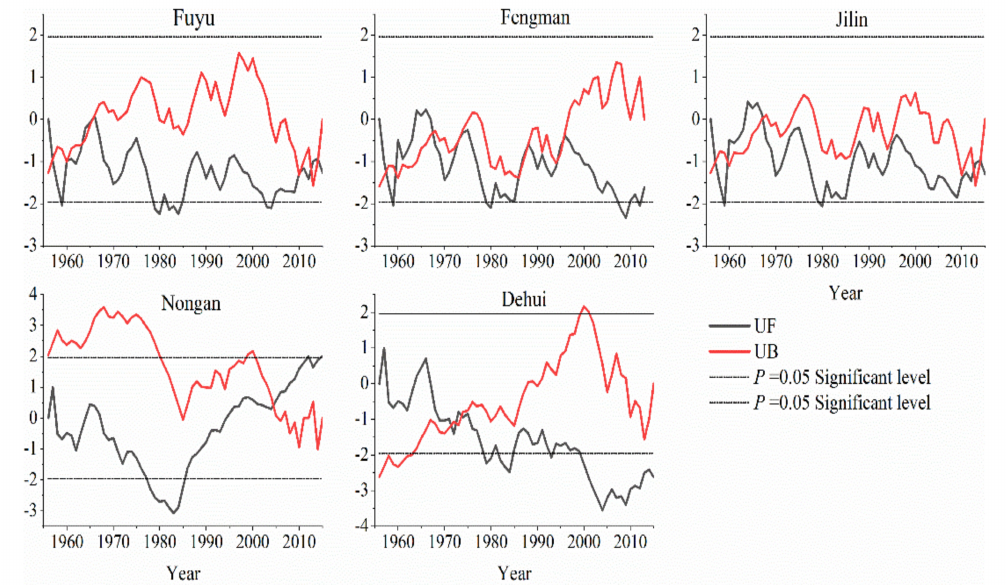
Figure 9. Results of the Mann–Kendall (M–K) mutation point test in partitions of the